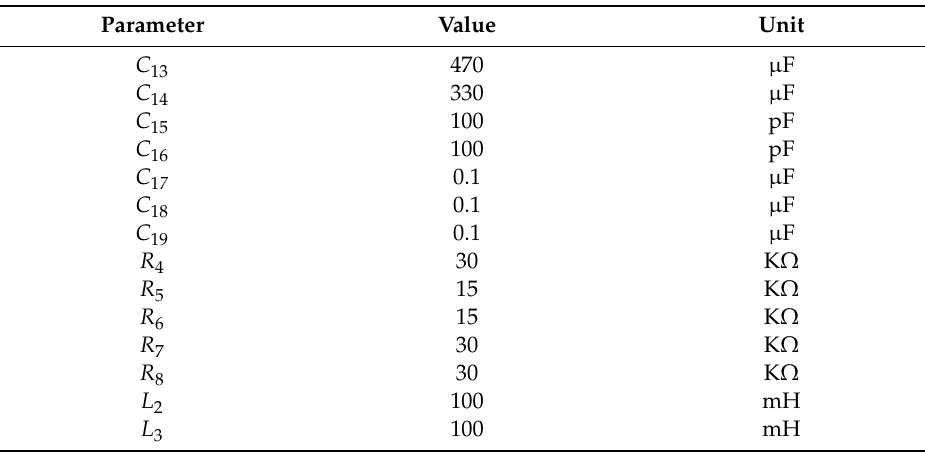
Table 11. Relevant parameters of the solar / wind charging circuit.